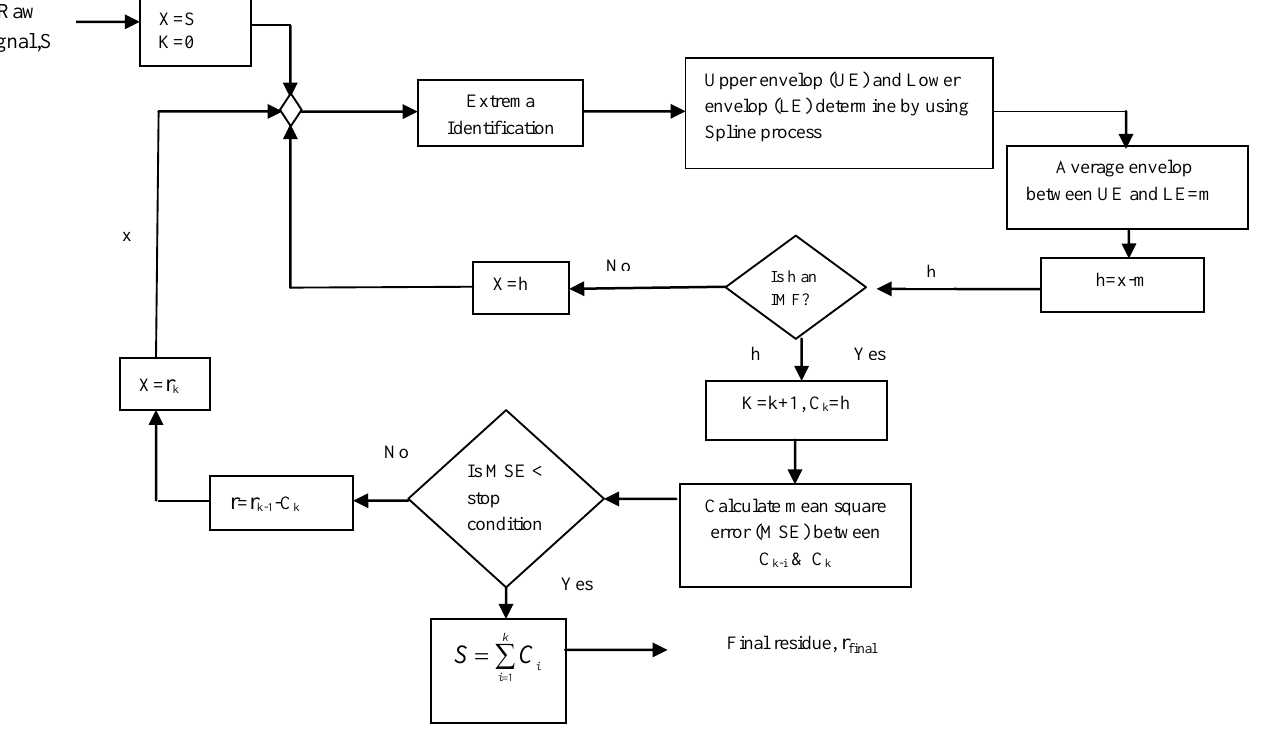
Figure 3. Block diagram of Empirical Mode Decomposition